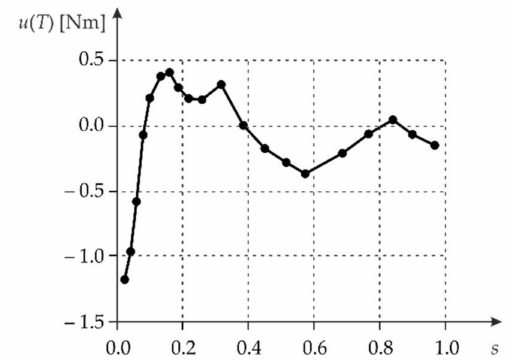
Figure 8. Distribution of the approximation uncertainty for the TSC characteristic.